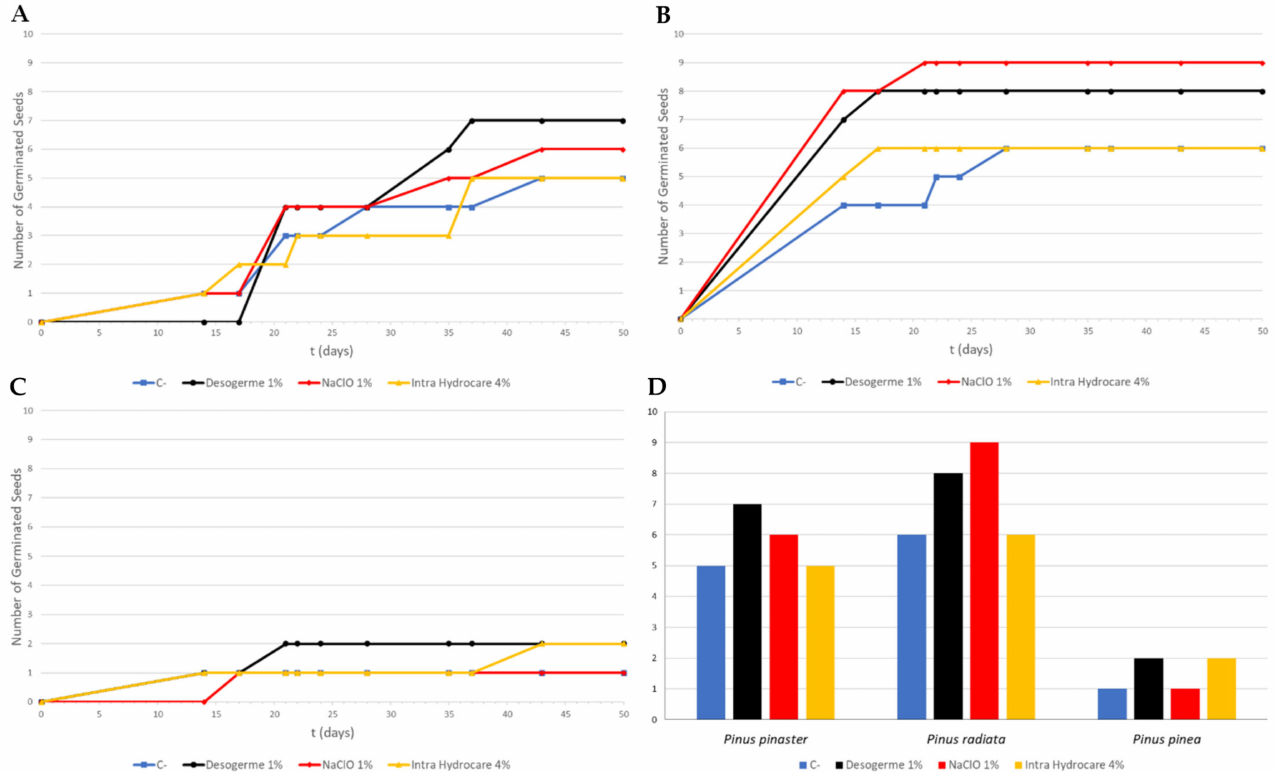
Figure 1. Number of germinated seeds of ( A ) Pinus pinaster , ( B ) Pinus radiata and ( C ) Pinus pinea throughout 50 days per treatment. ( D ) Total number of germinated seeds after 50 days per treatment and